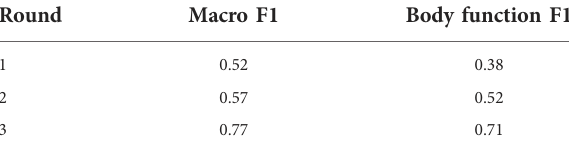
TABLE 3 Inter-rater agreement between two annotators.